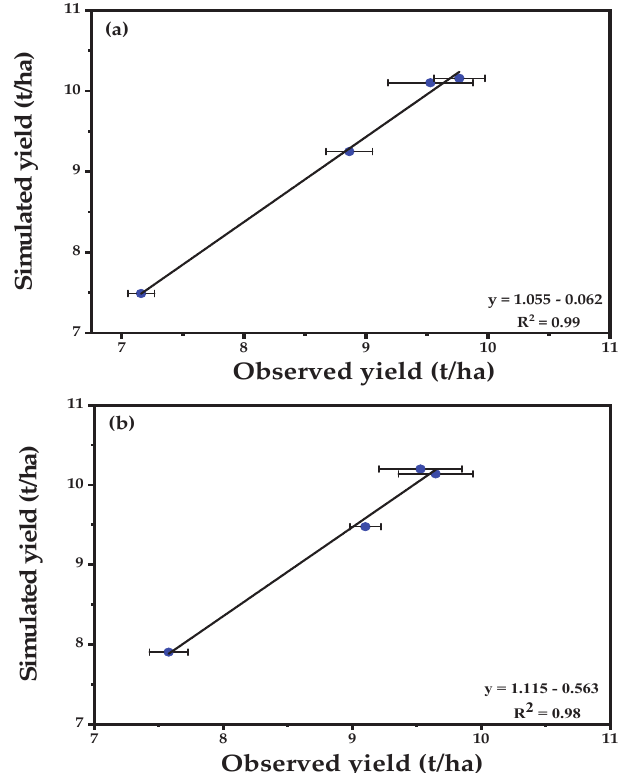
Figure 10. Observed and simulated rice yield during ( a ) 2019 and ( b ) 2020 under four irrigation regimes. The correlation (R 2 ) between the observed (x) and simulated (y) yield is considered good (R 2 > 0.5). Error bars indicate standard deviation among the three replicates.